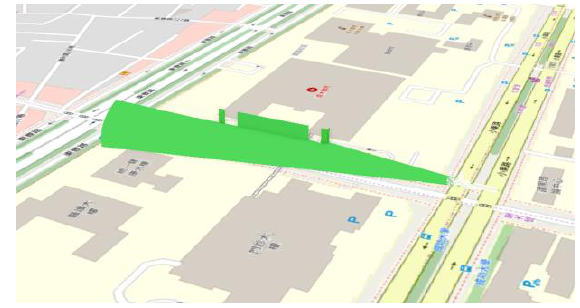
Figure 10 The coverage of single CCTV The scenario in Figure 11 illustrate the relationships between the viewshed outcome and the introduced city phenomena (building, network or other_area in this research). The multiplesurface depicted by the color of blue indicates the visible region from the given CCTV.